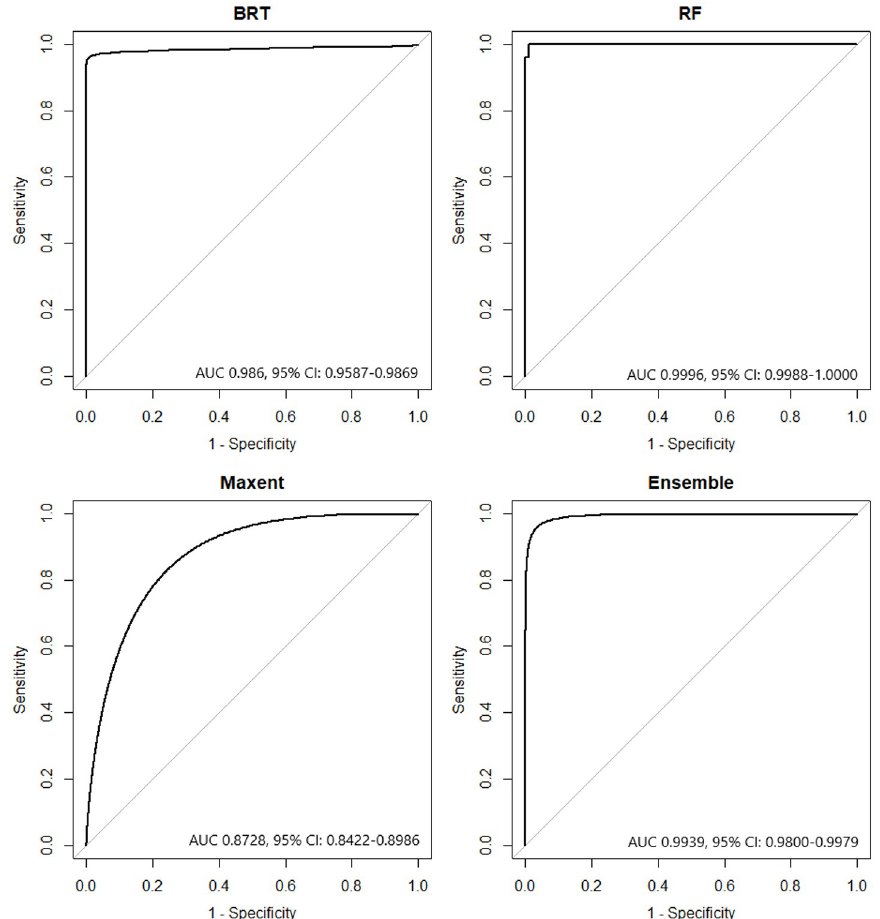
Fig 6. Model receiver operating characteristic curves. BRT—boosted regression tree, RF—random forest, Maxent— maximum entropy. The area under the curve value for each model with its 95% confidence interval is indicated.